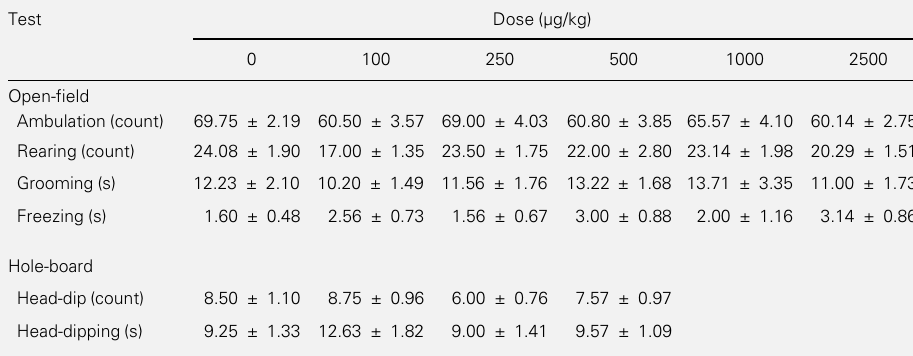
Table 1 - Behavioral effects induced by irradiated crotoxin on rats submitted to the open-field and hole-board tests. Rats were injected intraperitoneally with irradiated crotoxin or saline 2 h before the hole-board (100, 250, and 500 (cid:181)g/ kg) and open-field (100, 250, 500, 1000, and 2500 (cid:181)g/kg) tests. Data are reported as the mean – SEM for 8-10 animals per group. Dose zero corresponds to control. No significant effects were demonstrated with